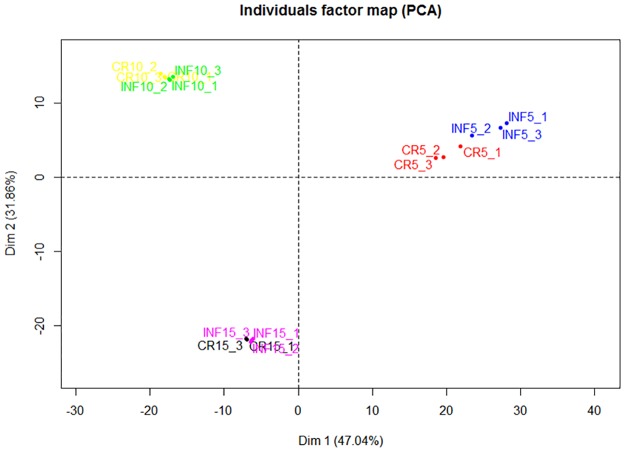
Principal component analysis of RNA-seq data.Gene expression changes were investigated at days 5, 10 and 15 P.I. in honeybees infected (INF) with N. ceranae or no treatment (CR). The PCA was performed using normalized RNA-Seq data of 675 genes differentially expressed in at least one pairwise comparison: control vs infection at day 5 10 P.I or 15 P.I.Clear differences were seen between samples collected at days 5, 10 and 15 suggesting that ageing of the bees has a larger effect on the pattern of gene expression pattern than infection status.